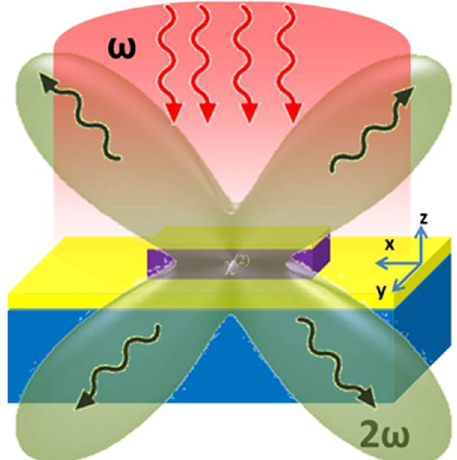
Figure 1. Schematic representation of the structure investigated in the first part: the red illumination represents the plane-wave excitation used and the green emission pattern represents the multipolar radiation at the second harmonic (SH) frequency. Dielectric cuboid dimensions x , y , z : 0.7 µ m × 0.22 µ m × 0.18 µ m. Top metal thickness 40 nm. Partial gold backplane thickness 110